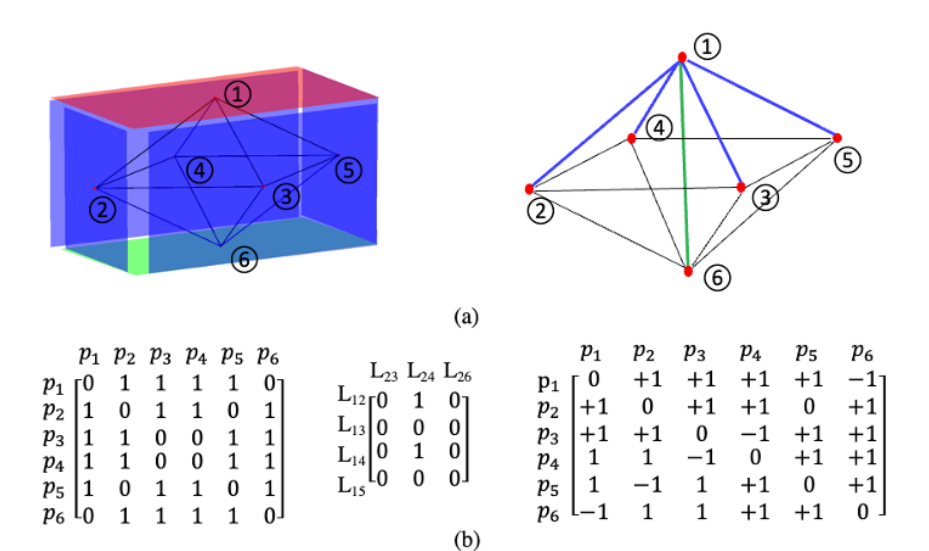
Figure 4. Set of extracted primitives (with boundary) and the corresponding relations: ( a ) graph- based representation and ( b ) matric representation. p i stands for plane i, L i j for the intersection of p i and p j . The value in the matrix denotes the relationship, with + 1 and − 1 representing the parallel and vertical relationships. 0 is the plane